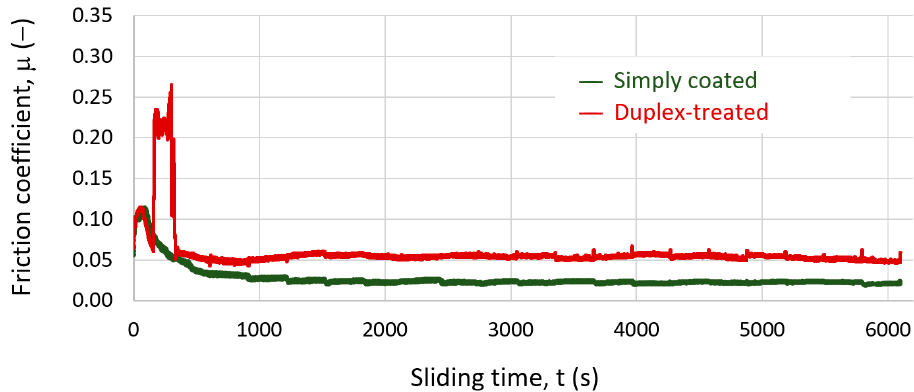
Figure 6. Friction coefficient vs. time curves obtained during the wear testing of the simple-coated and duplex-treated samples.